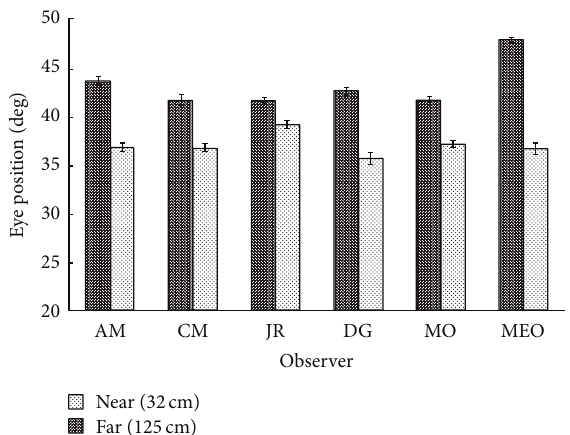
Figure 5: Mean position of the temporally directed eye ( ± SEM) at the limit of the bifixation field as a function of convergence